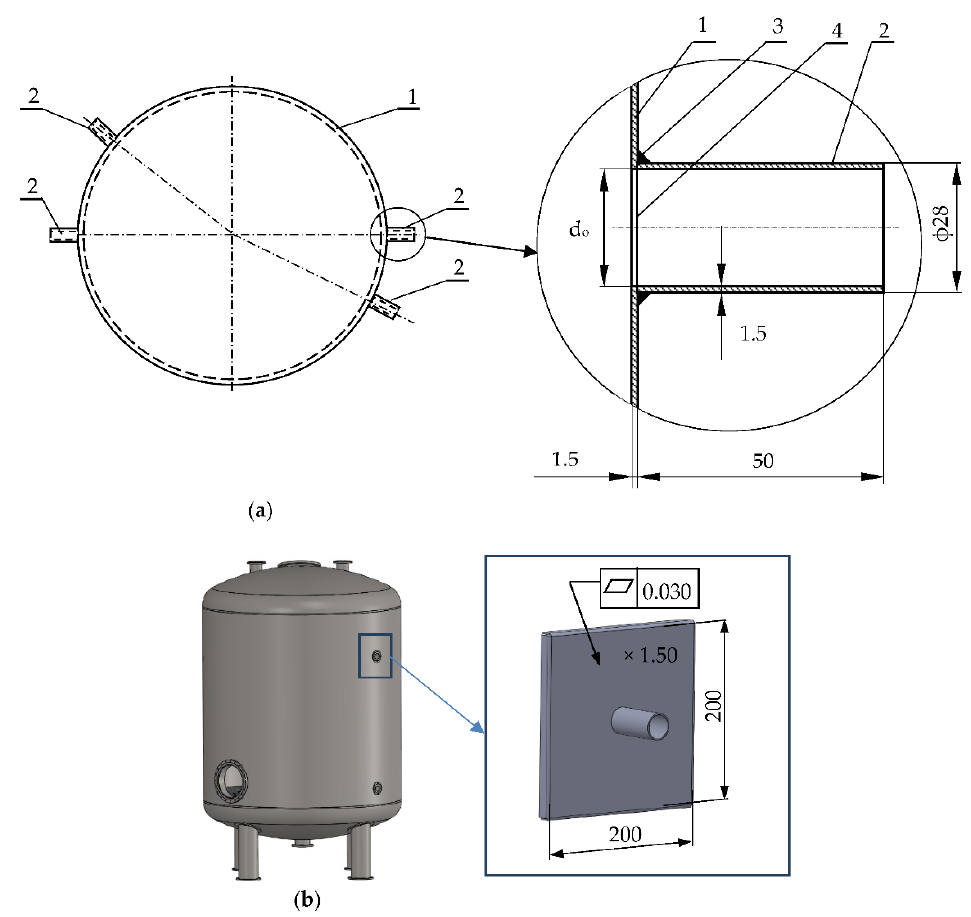
Figure 3. Welded tank structure: 1—cylindrical tank, 2—stub pipe, 3—one-sided fillet weld, 4—opening in the tank for the stub pipe ( a ), a test sample with modeled tank jacket area ( b ).